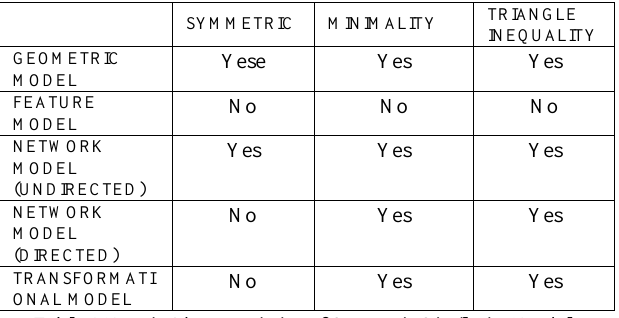
Table 1 Metric Characteristics of Semantic Similarity Models